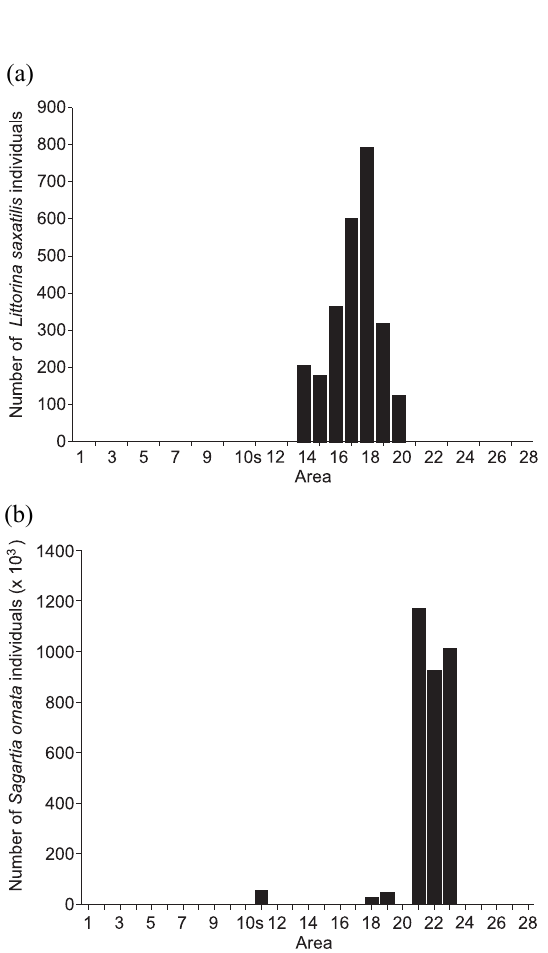
Fig. 3. Total number of individuals of (a) Littorina saxatilis and (b) Sagartia ornata recorded in each sampling